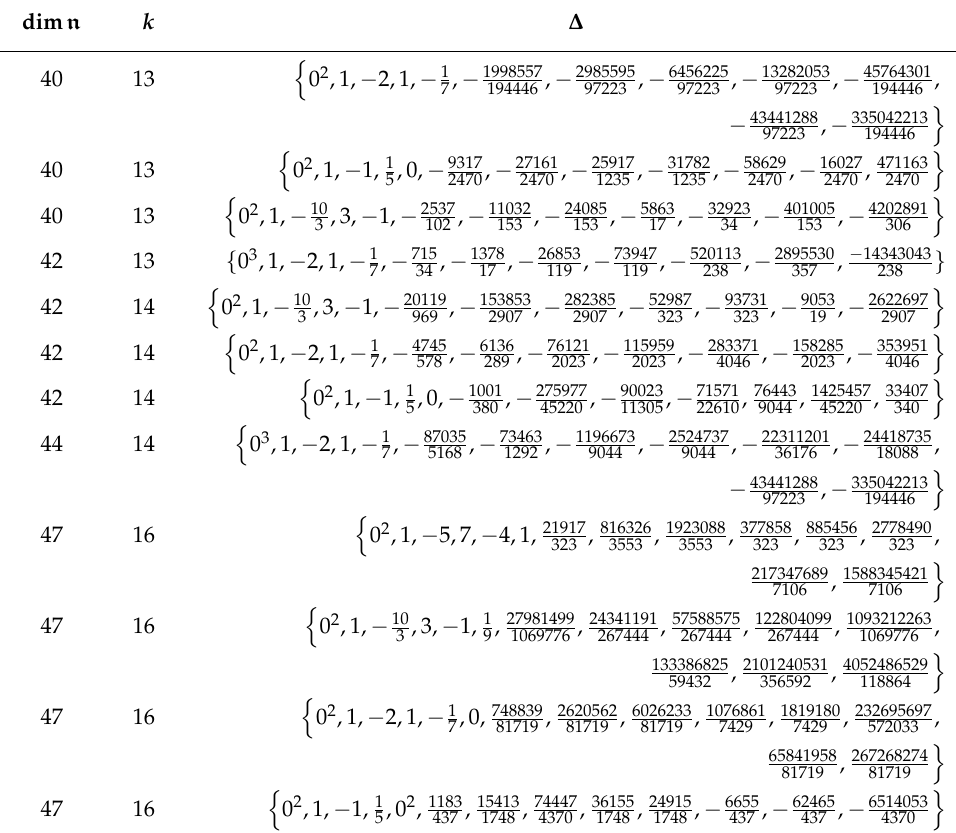
Table 3. Lowest-dimensional solutions for Subcase